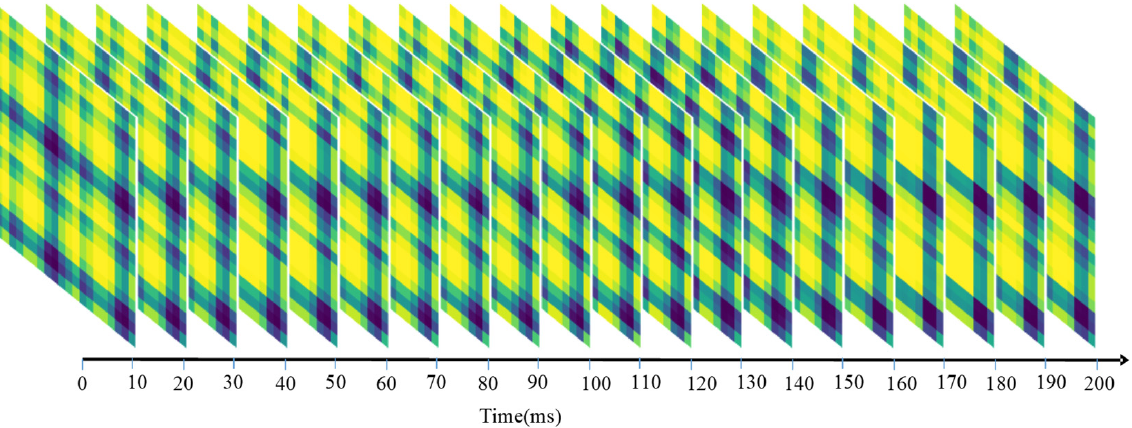
Figure 3. Sequential sEMG-GAF images obtained from the NinaPro DB1 dataset; 10-channel sEMG signals were sampled at 100 frames/second.